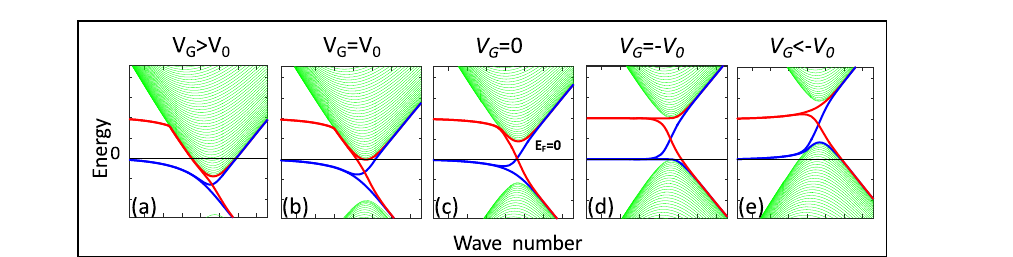
Fig. 9 | Tight-bindingmodelforgapped graphenewithan edge state pinnedat E=0 for various gate voltages, V G . a – e Conduction and valence band (green) and split edge state (blue and red) for increasing V G . For V G = V 0 in ( b ), the Fermi level grazes the bottom of the conduction band, which is where the Hall voltage of the